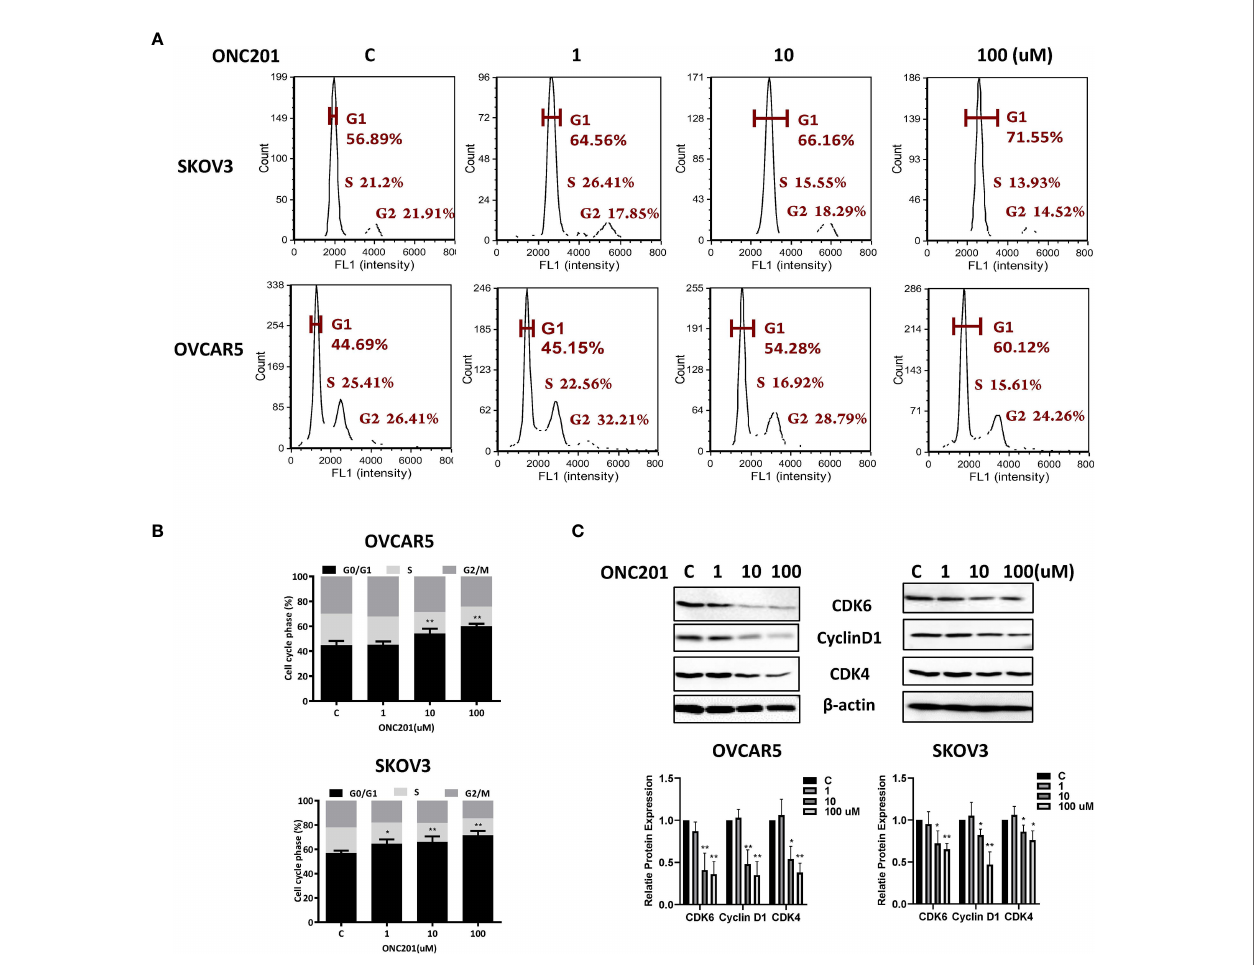
FIGURE 2 | Induction of cell cycle G1 arrest by ONC201 is dose-dependent. The OVCAR5 and SKOV3 cells were incubated with indicated doses of ONC201 for 36 hours. Cell cycle progression was assessed by Cellometer. Cell cycle G1 arrest was found in both cell lines in a dose-dependent manner (A, B) . The cells were exposed to 1-100 um ONC201 or the vehicle controls for 36 hours prior to western blotting for the detection CDK4, CDK6 and Cyclin D1. ONC201 decreased the expression of CDK4, CDK6 and Cyclin D1 in both cell lines. b -actin was used as loading control (C) . The results shown are one of three independent experiments. * <0.05, **